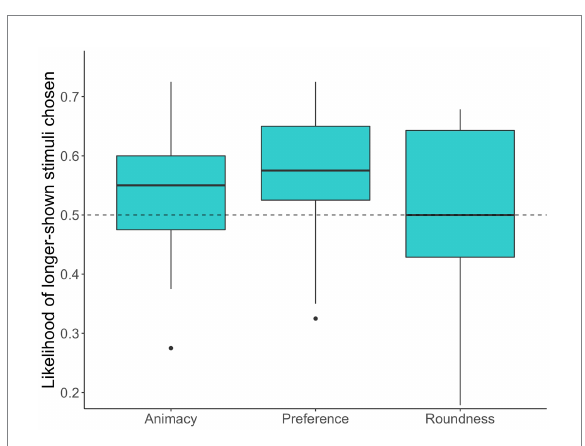
FIGURE 3 The box plots of the likelihood of the longer-shown stimuli chosen by participants across Studies 1a to 1c. The dashed line represents the chance level (50%).